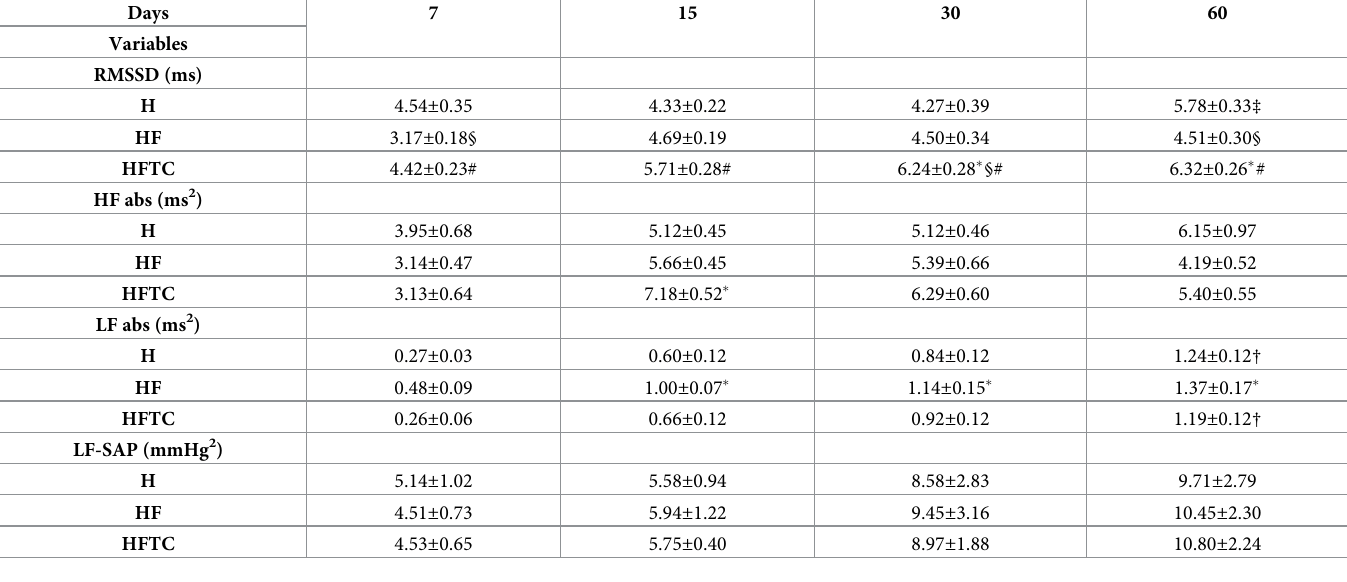
Table 2. Heart rate and systolic arterial pressure variability of the Hypertensive (H), hypertensive + fructose (HF) and hypertensive + fructose + combined physical training (HFTC) groups at 7, 15, 30 and 60 days.